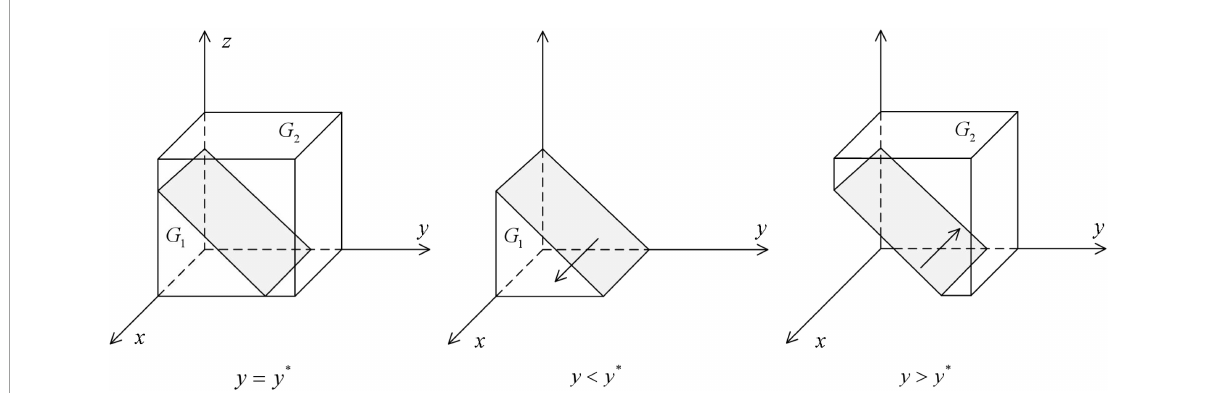
FIGURE1 Impact of changes in the probability of strategy of medical institutions on the ESS of the local government health departments.